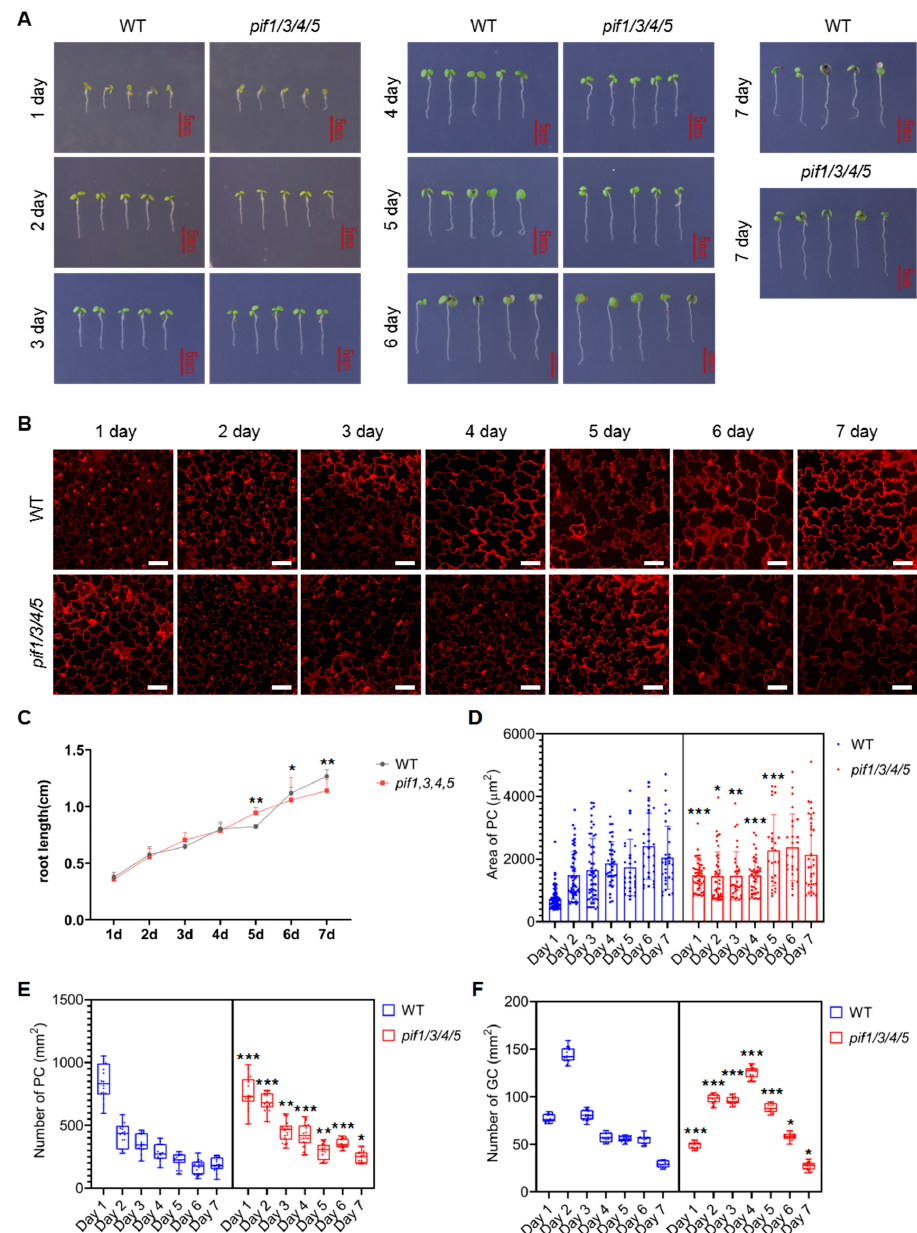
Figure 6. Analysis of the development of PC and GC in pif1/3/4/5 and WT under NaCl condition. ( A ) Analysis of the growth of pif1/3/4/5 and WT under control conditions. The seedlings of pif1/3/4/5 and WT were grown in 1/2 MS plates plus 100 mM NaCl for 1–7 days. The growth phenotype was recorded by photos, and untreated seedlings were used as controls—scale bar: 5 mm. ( B ) Detection of the development of PC and GC under the following conditions. The seedlings of pif1/3/4/5 and WT were grown in 1/2 MS plates plus 100 mM NaCl for 1–7 days and then harvested and stained with PI for 30 min to stain the membranes. After PI staining, the lower epidermis of cotyledons of seedlings was subjected to detect PC and GC’s developmental state on a laser confocal microscope. Scale bar: 50 µ m. ( C ) Statistical analysis of the root length of seedlings of pif1/3/4/5 and WT ( n = 5). ( D ) Statistical analysis of PC area in lower epidermis of cotyledons of seedlings of pif1/3/4/5 and WT ( n = 50). ( E ) Statistical analysis of the number of PC in lower epidermis of cotyledons of seedlings of pif1/3/4/5 and WT ( n = 10). ( F ) Statistical analysis of the number of GC in lower epidermis of cotyledons of seedlings of pif1/3/4/5 and WT ( n = 10). The data were analyzed by one-way ANOVA following Brown–Forsythe test. *: p < 0.05; **: p < 0.01; ***: p <